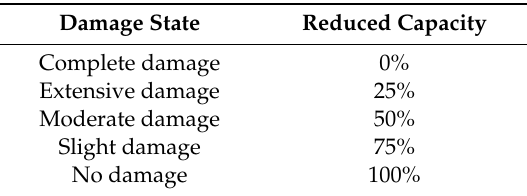
Table 1. Reduced capacities of damaged bridge structure.